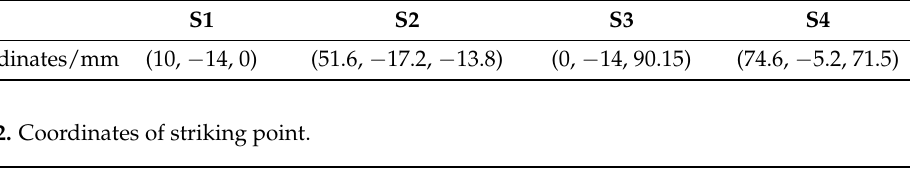
Table 1. Coordinates of strain gauge.